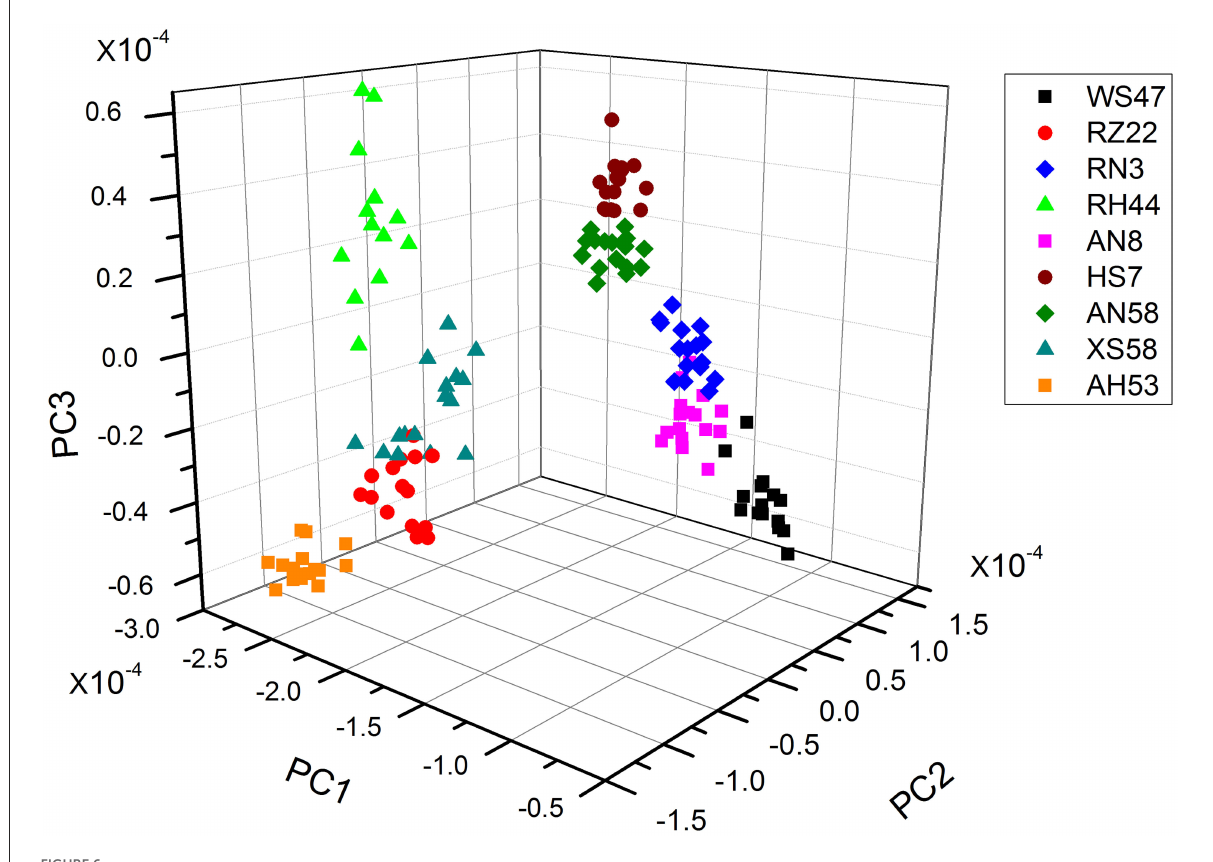
FIGURE6 PCA results of the proteins and polysaccharides region (ca. 1,200–900 cm − 1 ).